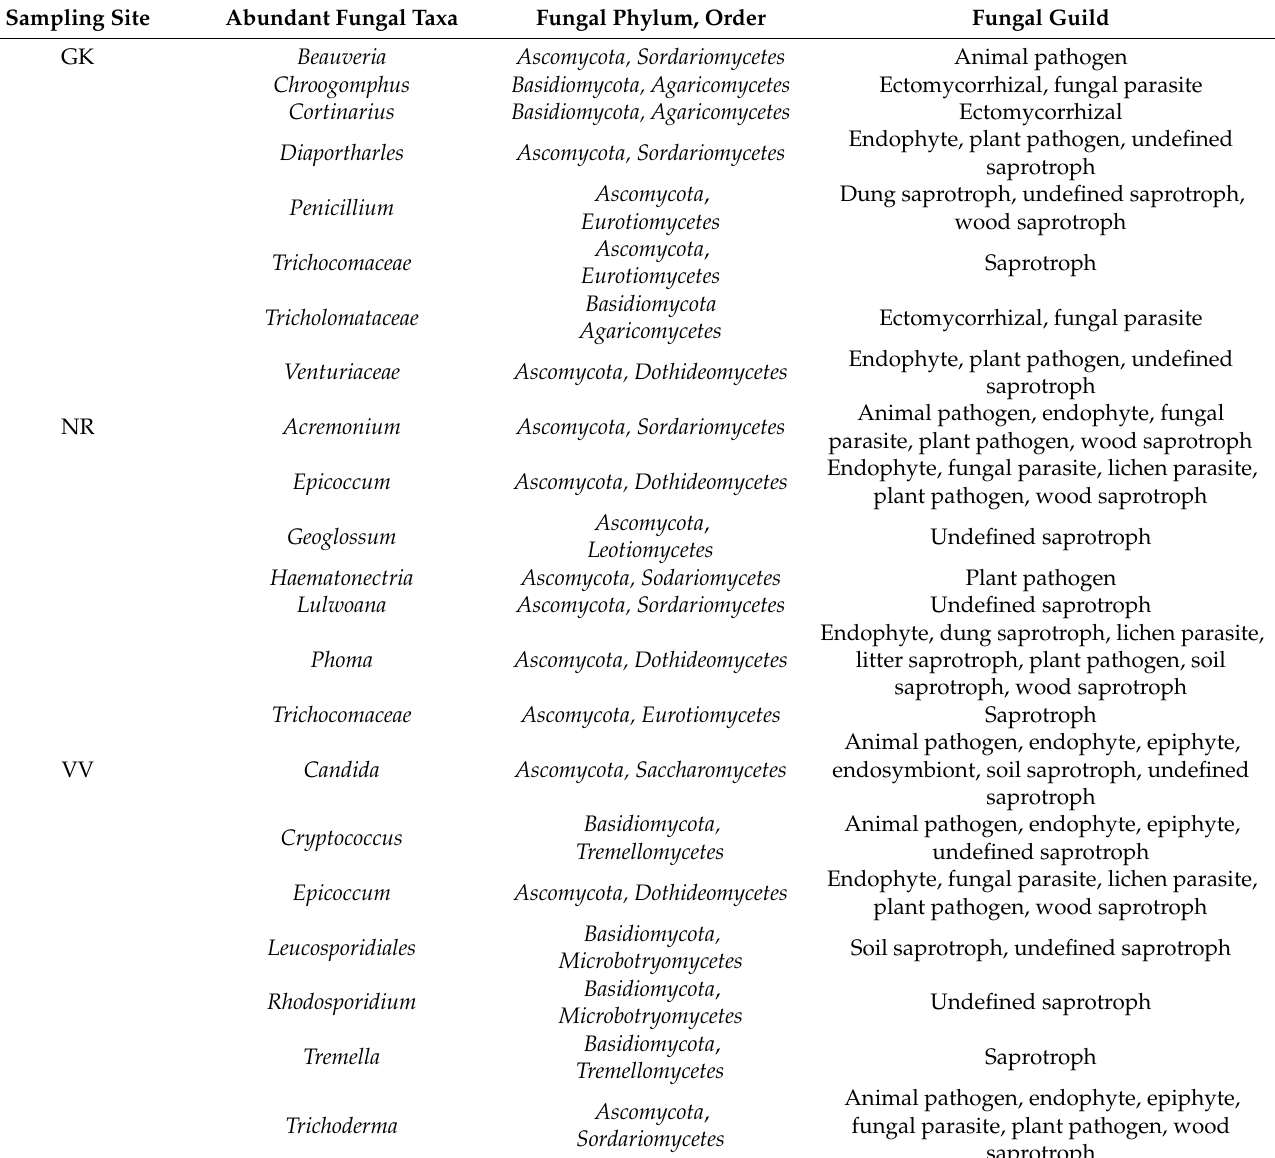
Table 6. Assignment of abundant fungal taxa from all three sampling sites to specific fungal guilds as determined using FUNGuild; GK = Goukou River system (impacted peatland); NR = Nuwejaars River system (developing peatland); VV = Vankervelsvlei (undisturbed